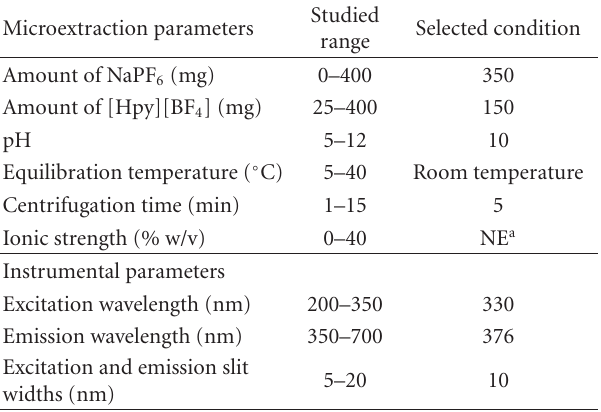
Table 1: The experimental conditions for terazosin determination.